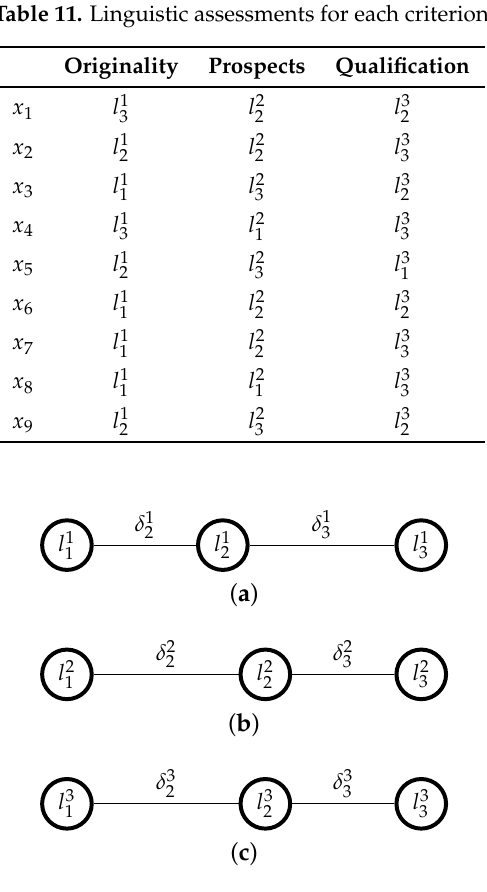
Figure 4. OPMs corresponding to the R&D criteria. ( a ) Metrizable OPM associated with the matrix A 23 ; ( b ) Metrizable OPM associated with the matrix A 32 ; ( c ) Metrizable OPM associated with the matrix A 32